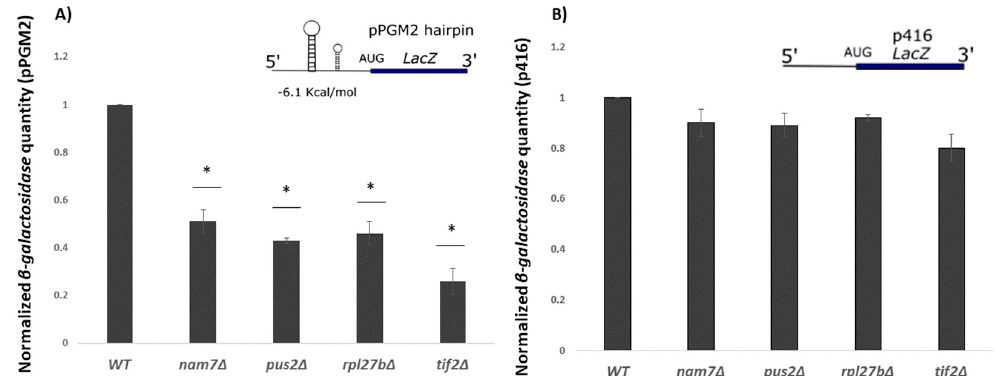
Figure 4. β -galactosidase expression analysis in different yeast strains. ( A ) Activities from β -galactosidase mRNAs that carry 5 ′ -UTR of PGM2 mRNA (pPGM2) upstream of LacZ reporter was reduced in nam7 Δ , pus2 Δ , and rpl27b Δ strains. Strains carrying low complexity regions upstream of LacZ reporters p416 ( B ) did not show as significant reductions in β -galactosidase activity. Values are normalized to that for WT which resulted in average β -galactosidase values of 38.1 U and 407.5 U for pPGM2 and p416 constructs, respectively. Each experiment was repeated at least three times ( n ≥ 3) and error bars represent standard deviation. * represents statistically significant results ( p -value ≤ 0.05) compared to the WT. t -test analysis was used to compare differences. The insets represent schematic reporter mRNA structures.